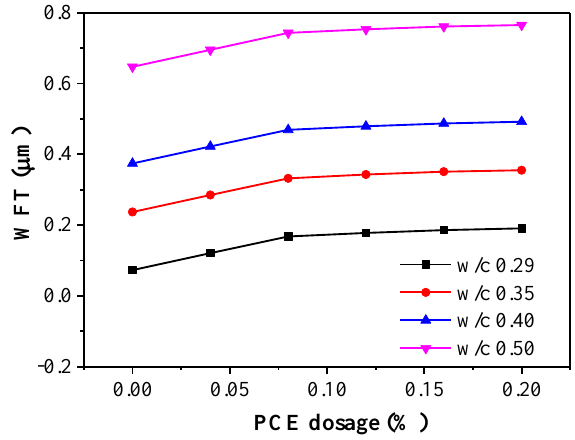
Figure 5. WFT versus PCE dosage for pastes with various w/c